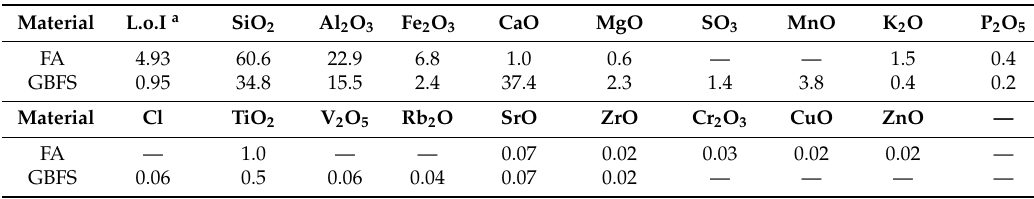
Table 1. Chemical composition (% mass) of the tested fly ash (FA) and granulated blast-furnace slag (GBFS).